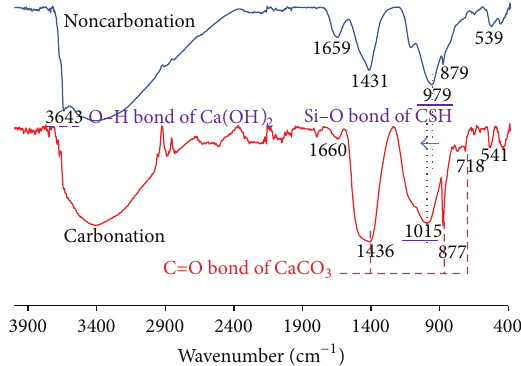
Figure 9: Fourier-transform infrared spectra of carbonated and noncarbonated OPC